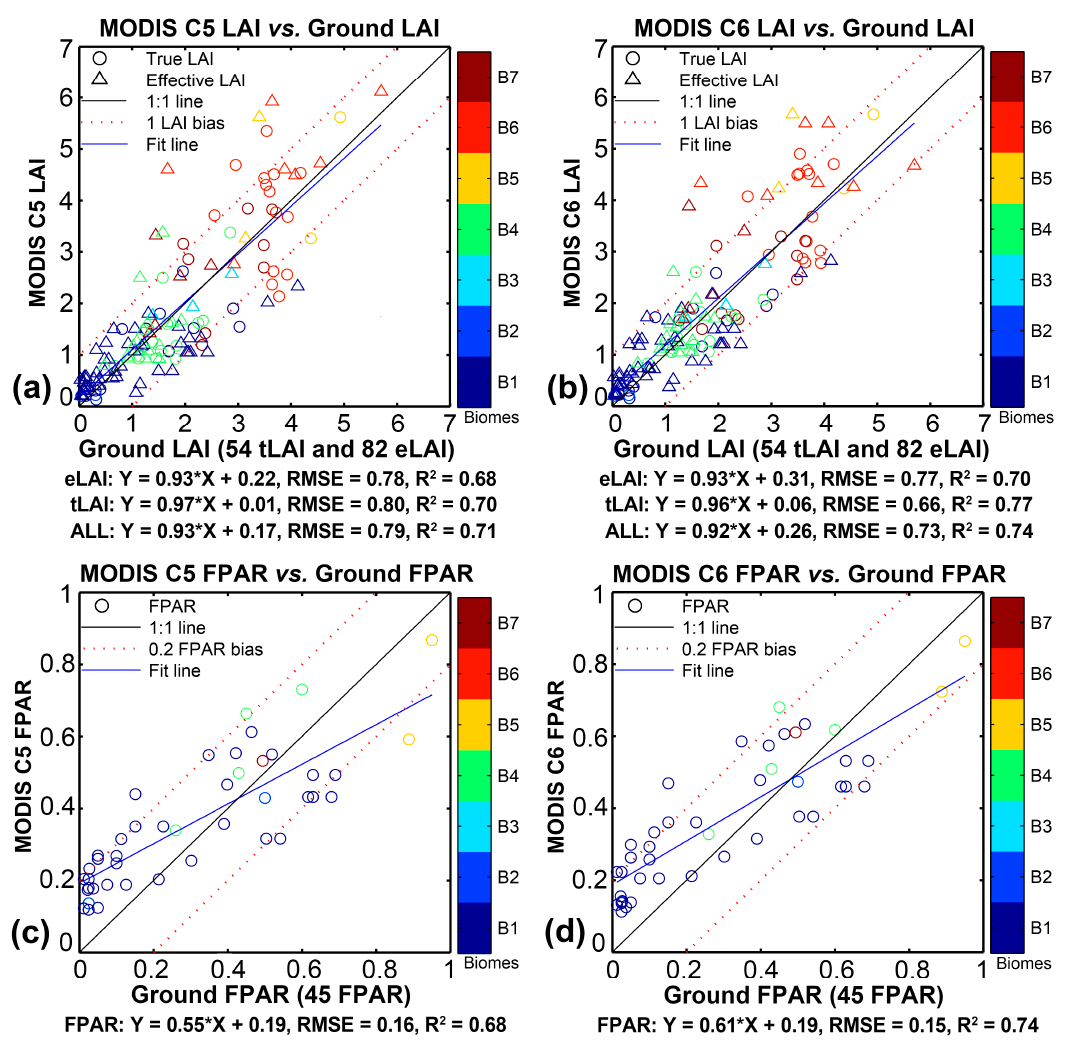
Figure 2. Comparisons between ground measured LAI ( a , b ) and FPAR ( c , d ) with MODIS C5 (left panels) and C6 (right panels) retrievals. Fifty four true LAI, 82 effective LAI and 45 FPAR measurements are used here. The 3 km × 3 km sites dominated by different biome types are depicted by different colors. Circles (triangles) in ( a ) and ( b ) represent ground LAI measurements corrected (not corrected) for clumping.